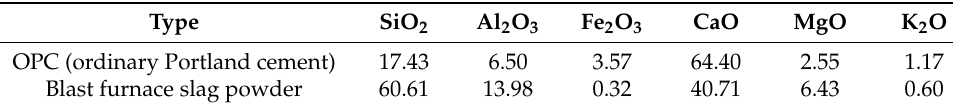
standard range. Figure 1. SEM images of NFA, BSA and FSA: ( a ) NFA, ( b ) BSA, ( c ) FSA. Figure 1. SEM images of NFA, BSA and FSA: ( a ) NFA, ( b ) BSA, ( c ) FSA Table 1. Chemical composition of cementitious materials. Table 1. Chemical composition of cementitious materials.